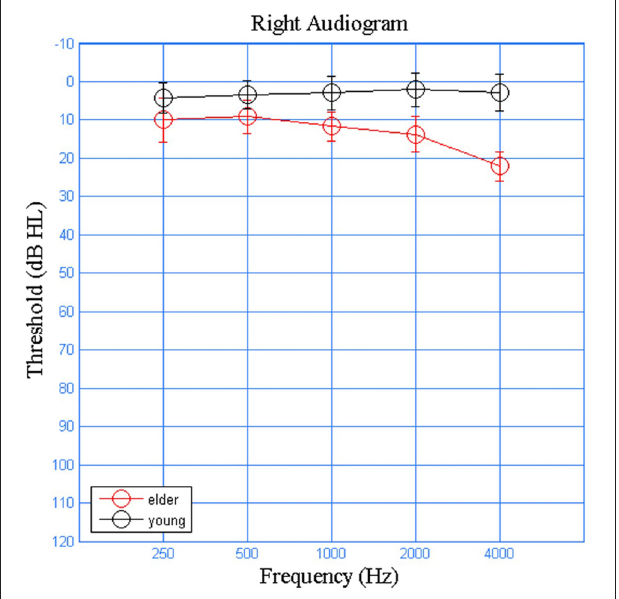
FIGURE 1 | Averaged audiograms for the young (black) and older (red) participants on the right ears. Air conduction audiometric hearing threshold were denoted by circles, where error bars represent the standard